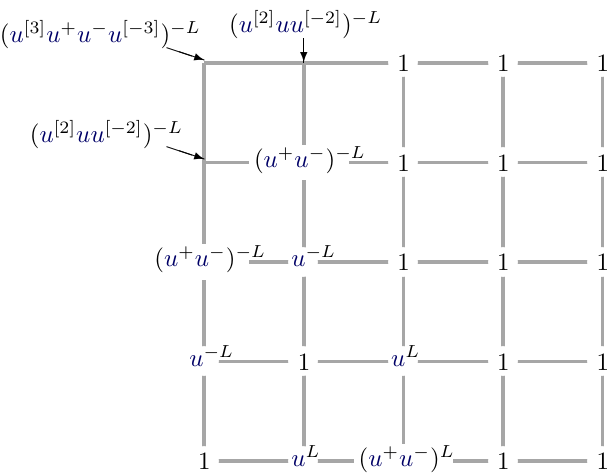
Figure 5 . The value of f a;s in the psu (2 ; 2 j 4)